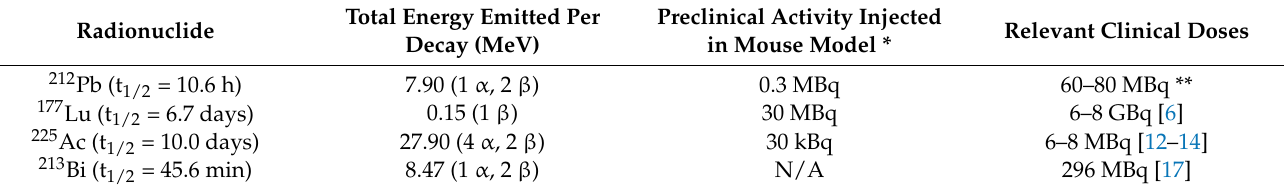
Table 5. Overview of the properties of relevant therapeutic radionuclides [65]. N/A, not available.